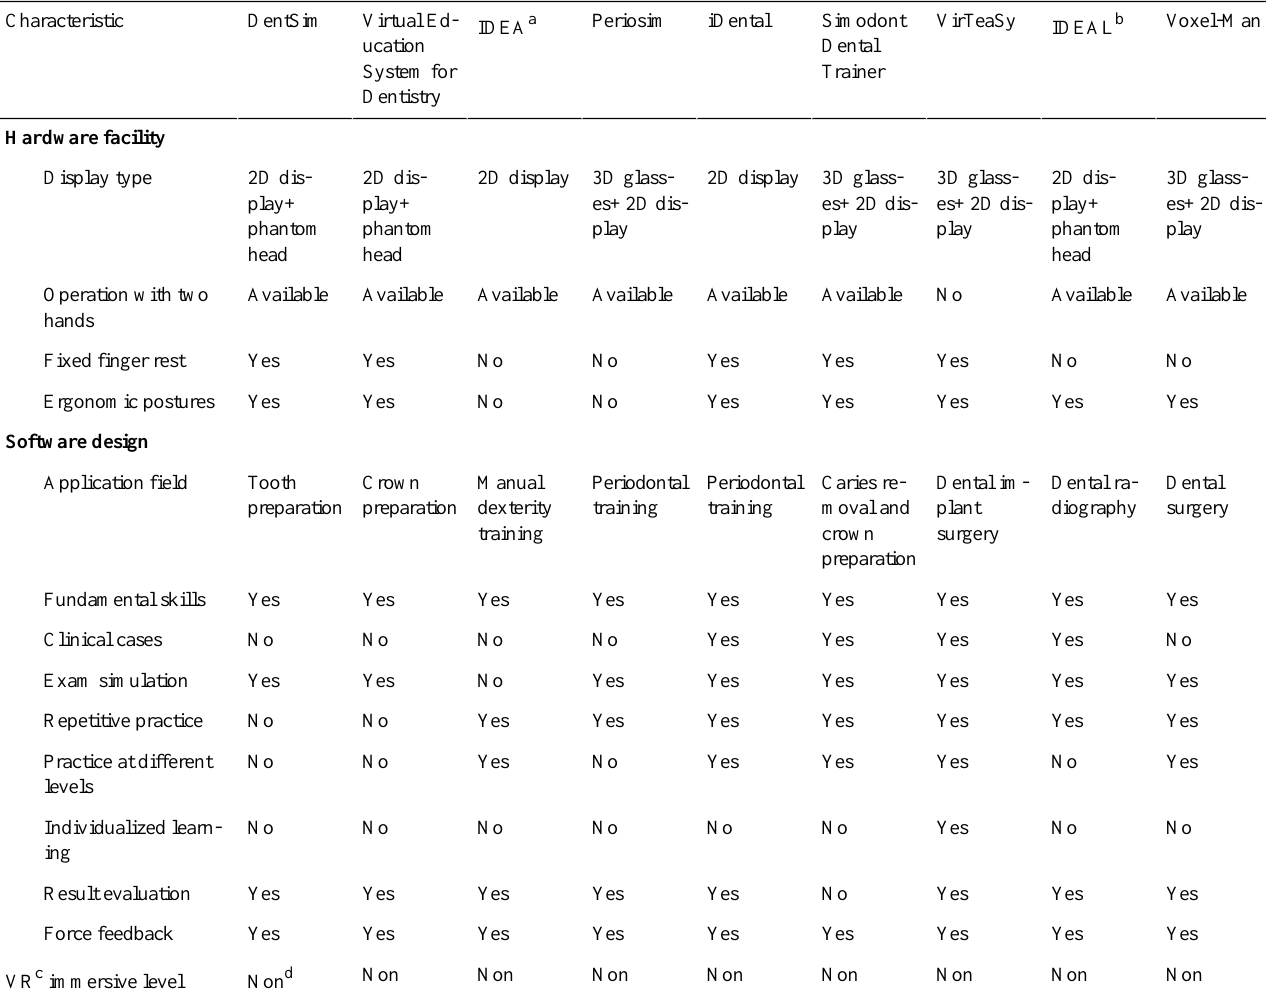
Voxel-ManIDEAL b VirTeaSySimodont